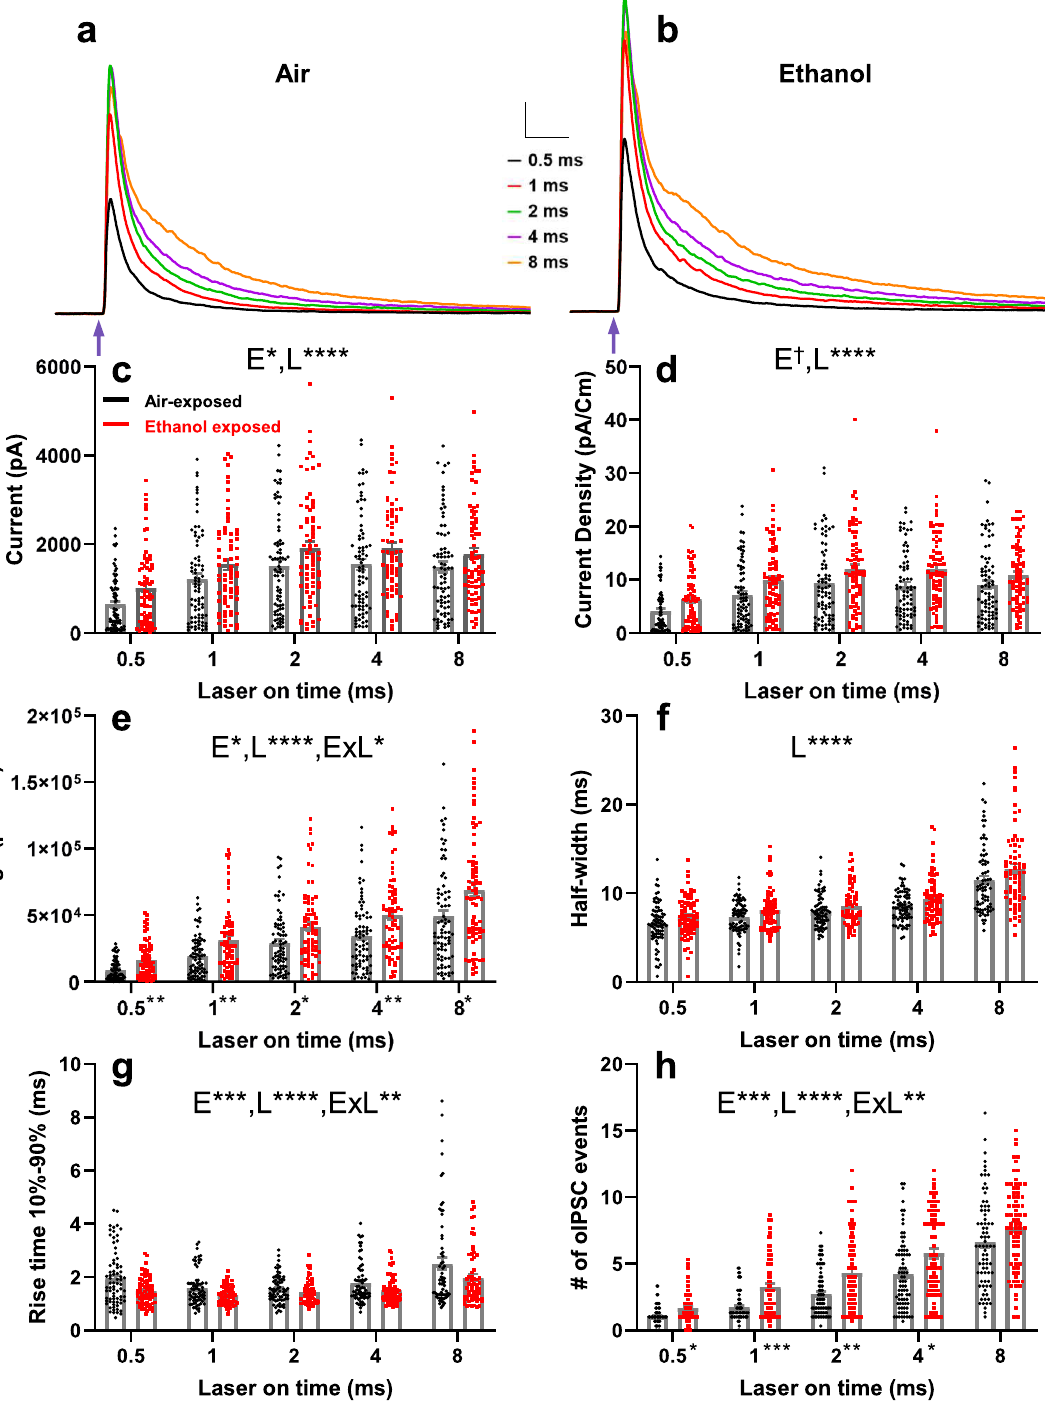
Figure 6. Effect of P7 ethanol exposure on optically-evoked inhibitory postsynaptic currents (oIPSCs) in layer V RSC pyramidal neurons at P40–60. ( a ) Average oIPSC current traces from air-exposed animals using 0.5 ms (black trace), 1 ms (red trace), 2 ms (green trace), 4 ms (purple trace), and 8 ms (orange trace) laser pulse durations. ( b ) Average oIPSC current traces from ethanol- exposed animals using 0.5, 1, 2, 4, and 8 ms laser pulse durations. Scale bars 20 ms, 200 pA. Blue arrows indicate onset of laser pulse. ( c – h ) Collected peak amplitudes ( c ), current densities ( d ), GABAergic total charge ( e ), half widths at half-maximum amplitude ( f ), rise times ( g ), and # of oIPSC events ( h ) for all cells from air exposed (black circles) and ethanol exposed (red squares) animals presented for each laser pulse duration. Data are presented collapsed across sex due to a lack of sex effects from LMM analyses. Dagger ( † ) denotes a p-value of < 0.06, and asterisks (*, **, ***, ****) denote p-values of p < 0.05, p < 0.01, p < 0.001, and p < 0.0001, respectively. Please see Supplemental Tables S2 and S3 for exact p-values from LMMs and post hoc tests, respectively. LMM effects: E = exposure effect, L = laser pulse duration effect, ExL = exposure by laser pulse duration interaction. Significance indicators next to x-axis laser pulse duration labels of panel ( e ) and panel ( h ) indicate a Mann–Whitney U post hoc effect of exposure within laser pulse duration. Female air n = 32 cells from 8 animals from 7 litters, male air n = 46 cells from 9 animals from 8 litters; female ethanol n = 35 cells from 8 animals from 8 litters, male ethanol n = 40 cells from 8 animals from 7 litters. Data are presented as mean ±